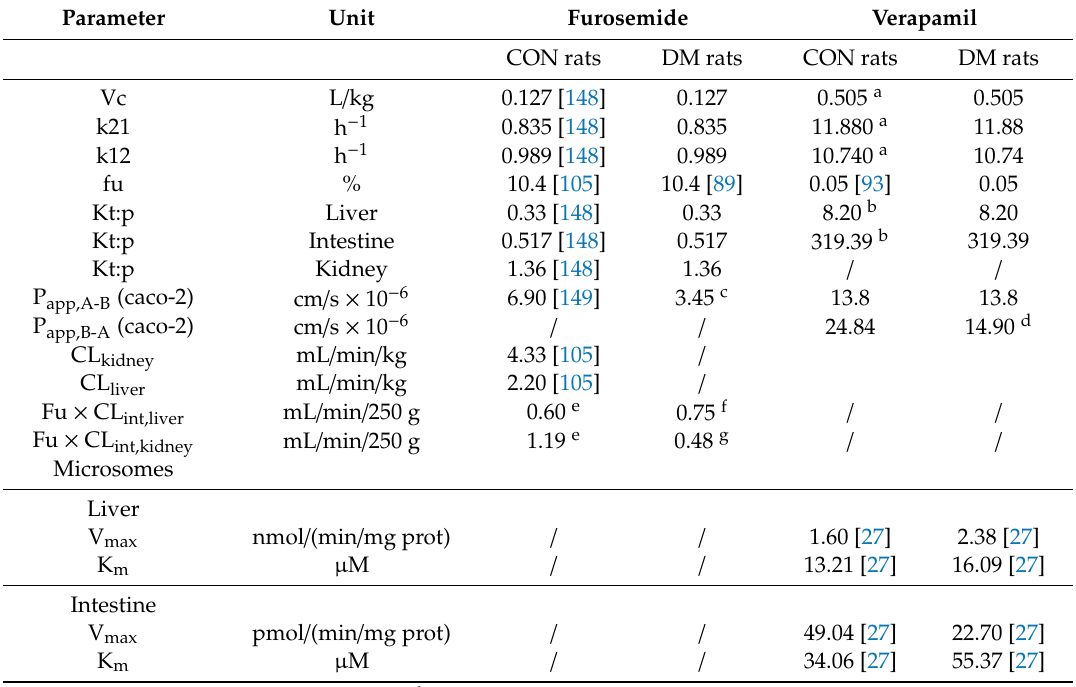
Table 2. Pharmacokinetic parameters of verapamil and furosemide for PBPK simulation in diabetic rats (DM) and control rats